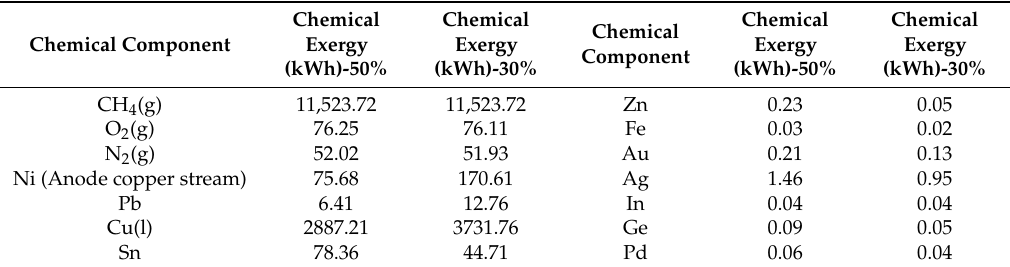
Table 7. Exergy values of materials going into the fire-refining stage.